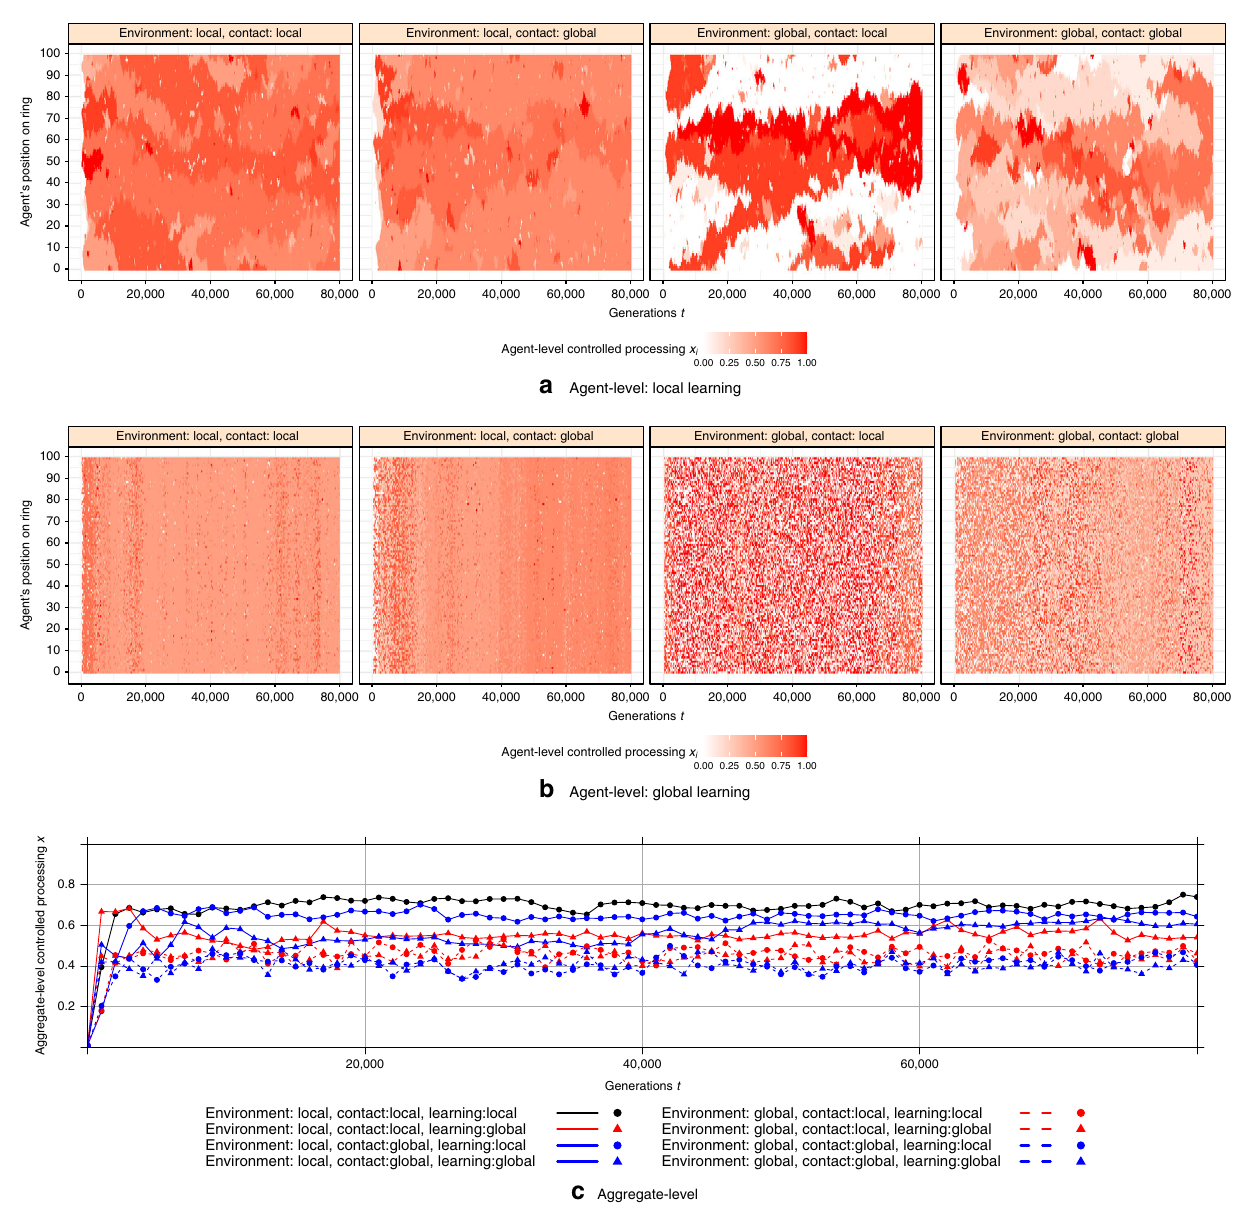
Fig. 2 Spatiotemporal dynamics of automatic versus controlled processing. a , b Represent agent-level controlled processing x for each condition of localness over 8 × 10 4 generations. Shown is the strategy of the agent in each location on the ring structure (on the y axis, such that pixels above and below each other are neighbors) at each generation (on the x axis), for each globalization scenario. a Shows results for global learning and panel (b) shows results for local learning. c Shows the aggregate-level controlled processing x over time for each condition of localness. Results are created for impact of automatic processing on the cost of controlled processing w = − 0.15 and fi xed cost of controlled c =